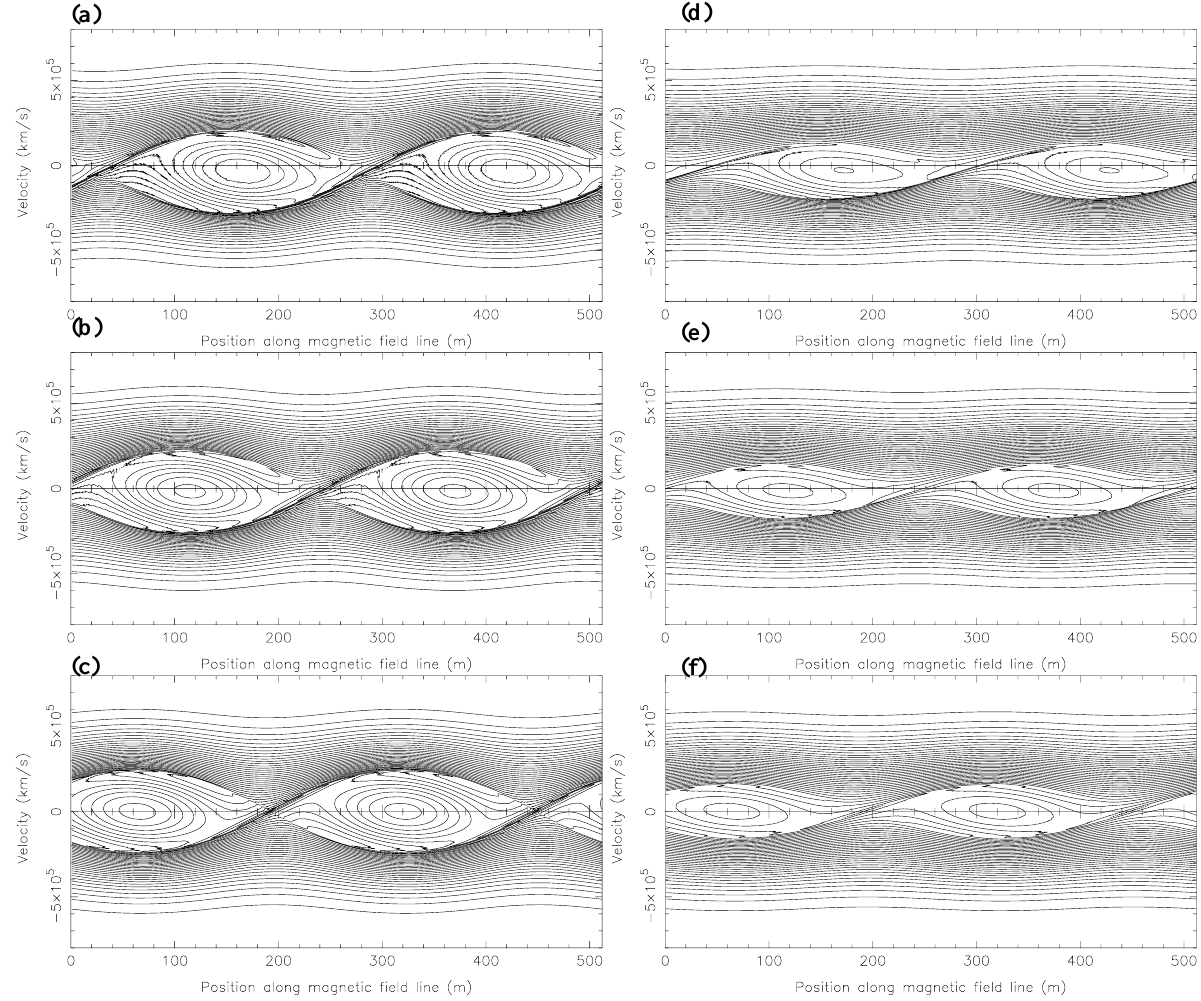
Fig. 4. Contours of EDF: (a) n ≡ 20% and V p =40km/s; (b) n ≡ 20% and V p =20km/s; (c) n ≡ 20% and V p =0km/s; (d) n ≡ 10% and V p =40km/s; (e) n ≡ 10% and V p =20km/s; (f) n ≡ 10% and V p =0km/s. The 256-m long simulation box is repeated to